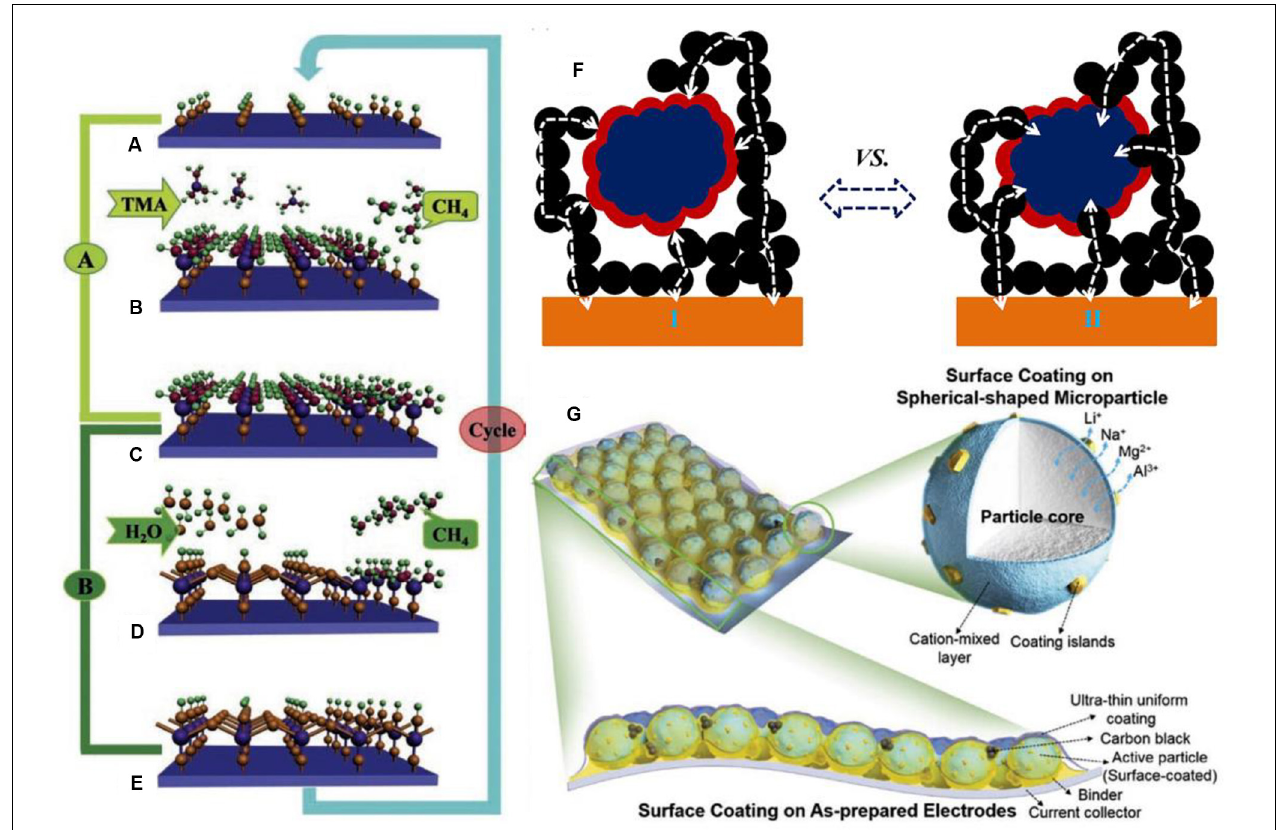
FIGURE 7 | The deposition model of the ALD process for different electrode surfaces. (A–E) The successive model of the ALD deposition process on Al 2 O 3 substrate using TMA and water as precursors. Reproduced with permission from Ref. Meng et al. (2012). Copyright 2012 Wiley-VCH. (F) Schematic illustration for ALD coating, (I) LCO powders, and (II) LCO cathode electrodes. Reproduced with permission from Ref. Li et al. (2014). Copyright 2014 Elsevier. (G) Schematic illustration of proposed hybrid surface coating strategy. Reproduced with permission from Ref. Kalluri et al. (2017). Copyright 2017